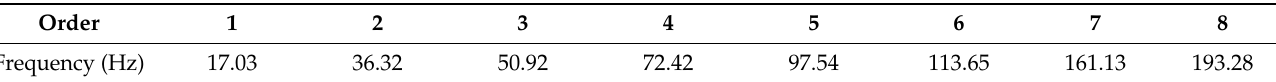
Table 7. The modal distribution of the machine tool.